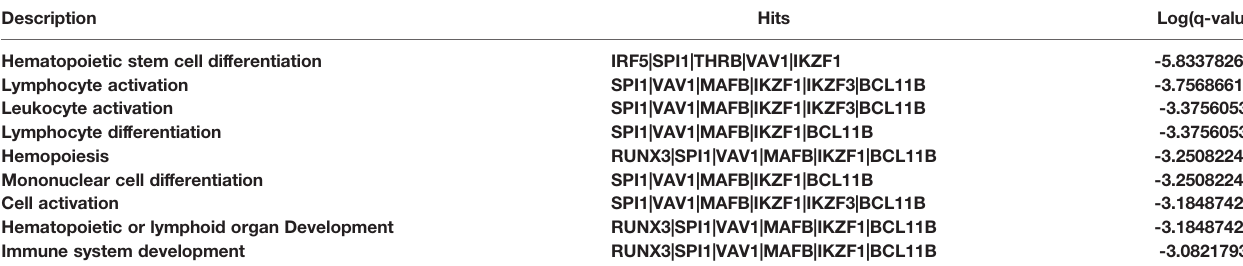
TABLE 2 | Functional enrichment results for transcription factors activated in the ovaries of women aged 30-39 years. Description